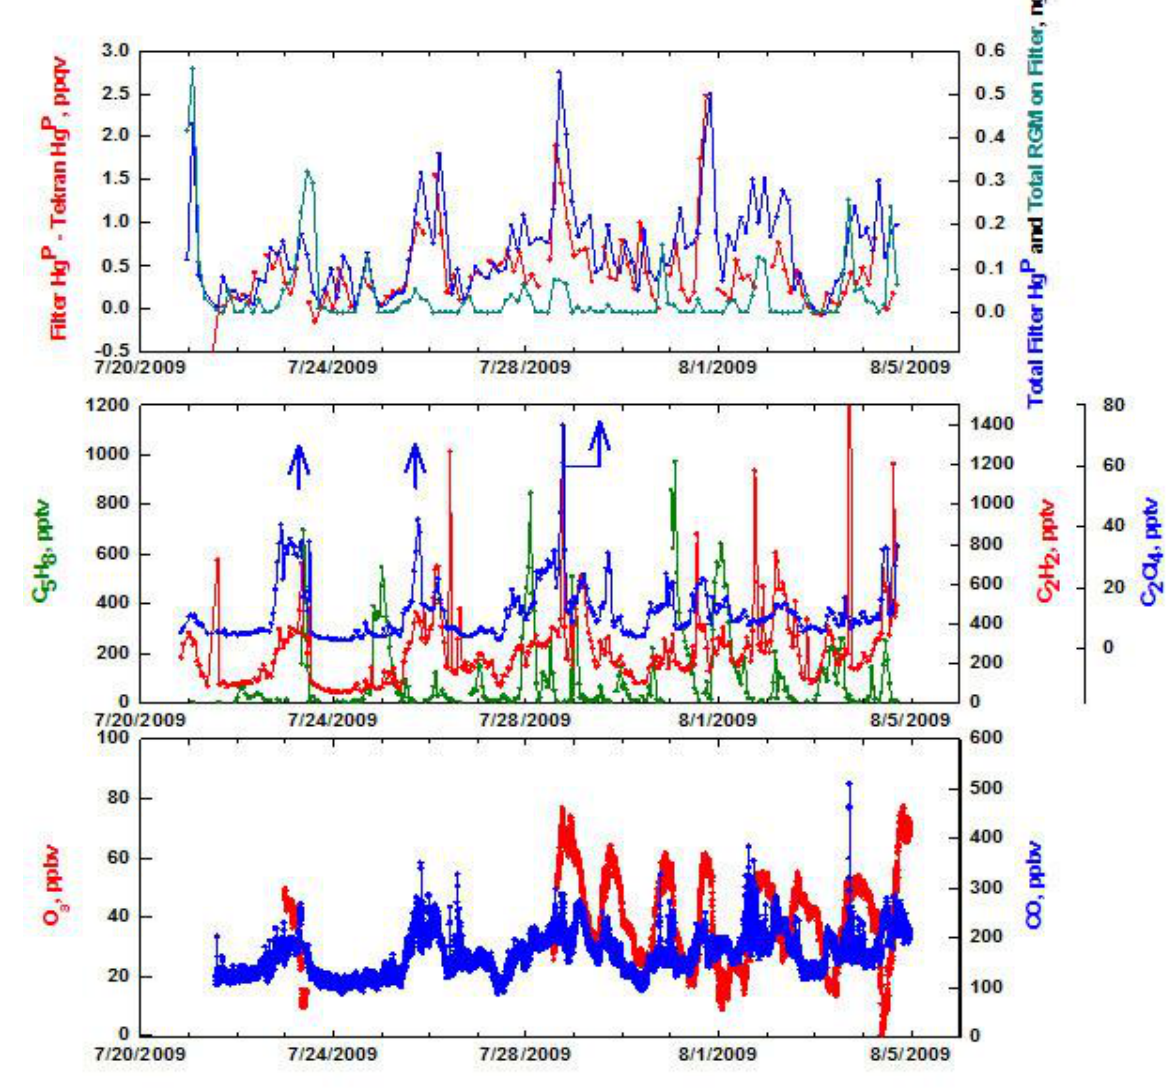
Figure 5. Top Panel—Comparison of total Hg on filter and from potential collection of all RGM on filter during summer sampling interval on Appledore Island. Middle Panel—Selected hydrocarbon/halocarbon time series. Bottom Panel—Times series of O and